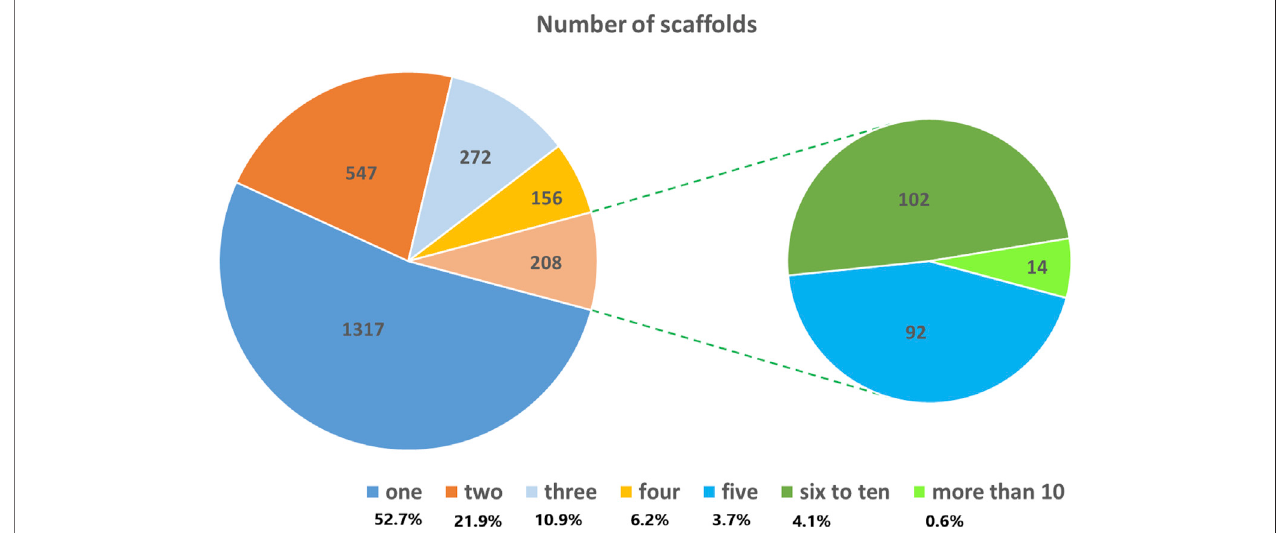
FIGURE 1 | Pie chart showing the distribution of the 5,226 SNPs used for genetic diversity analysis across the scaffolds of the fi nger millet reference genome.